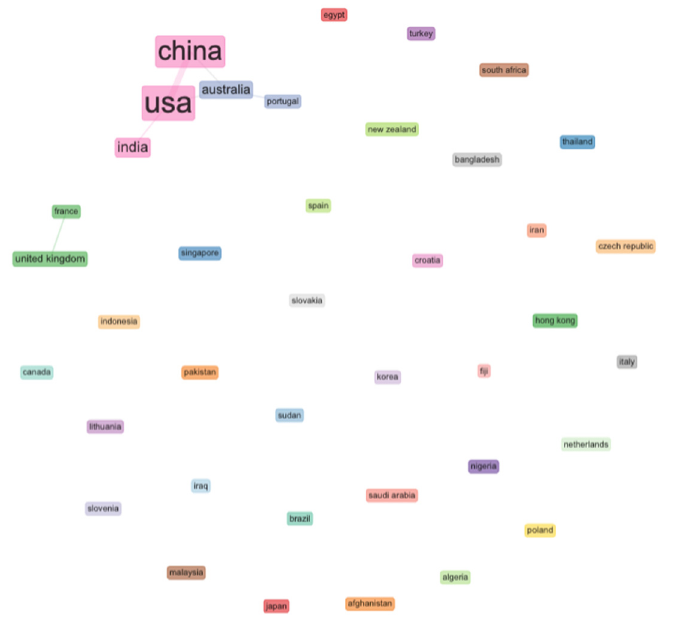
Figure 5. Countries’ scientific collaboration map on geosyinthetics research entrenched with manage- rial implications, as considered in this study.